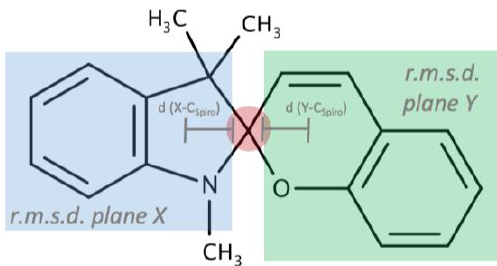
Figure 7. Definition of stated parameters for structure comparison.